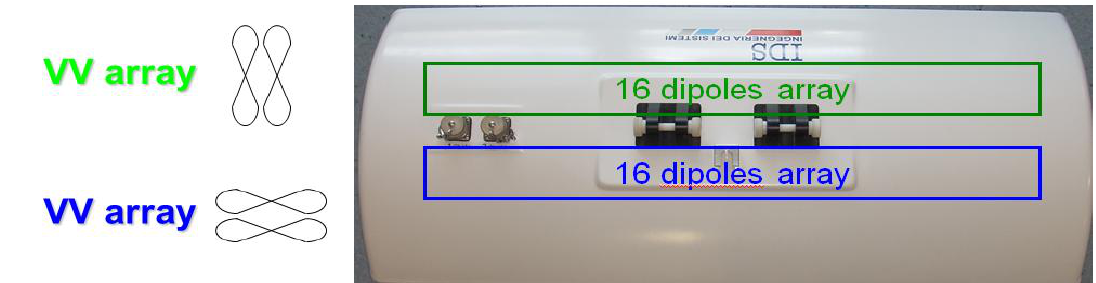
Figure 7. The IDS Hi BriT (2 GHz) antenna V16 H16 array: layout